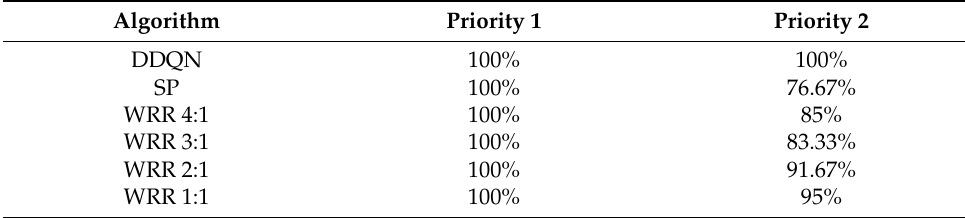
Table 9. WRR result at S4 according to different weights in topology.